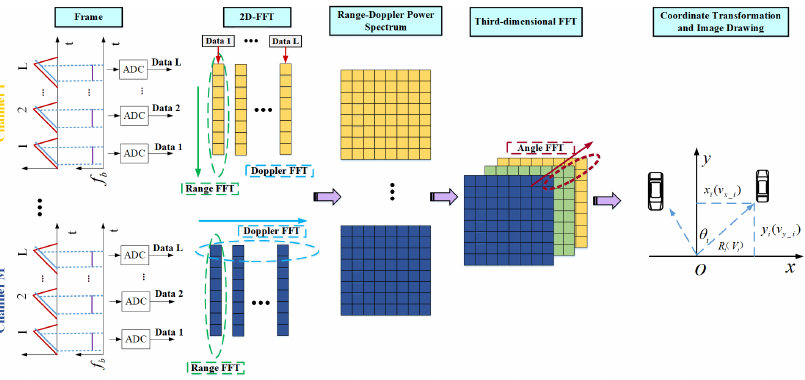
Figure 2. A typical radar imaging process flow based on the 3D-FFT